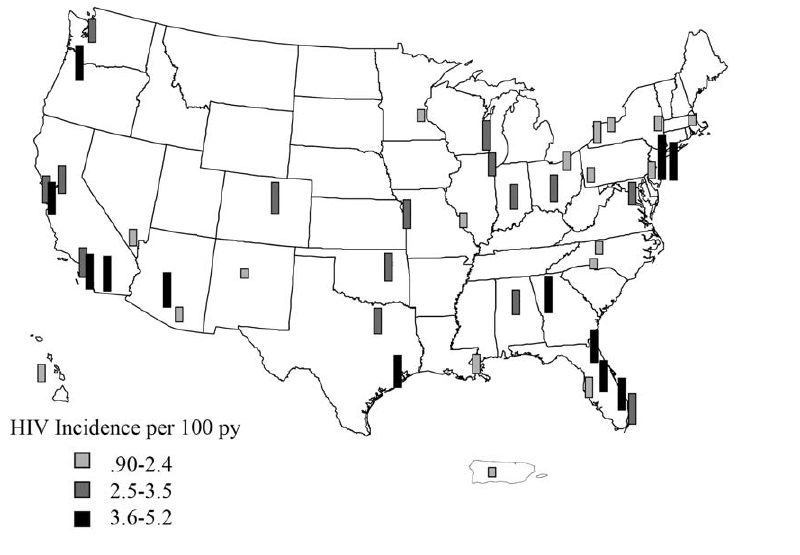
Figure 1. HIV incidence among MSM study participants in the United States, by city, 1998–2002*.